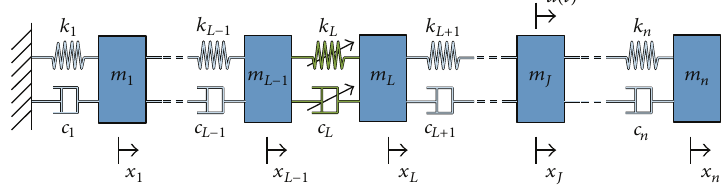
Figure 1: A one-dimensional MDOF system with local